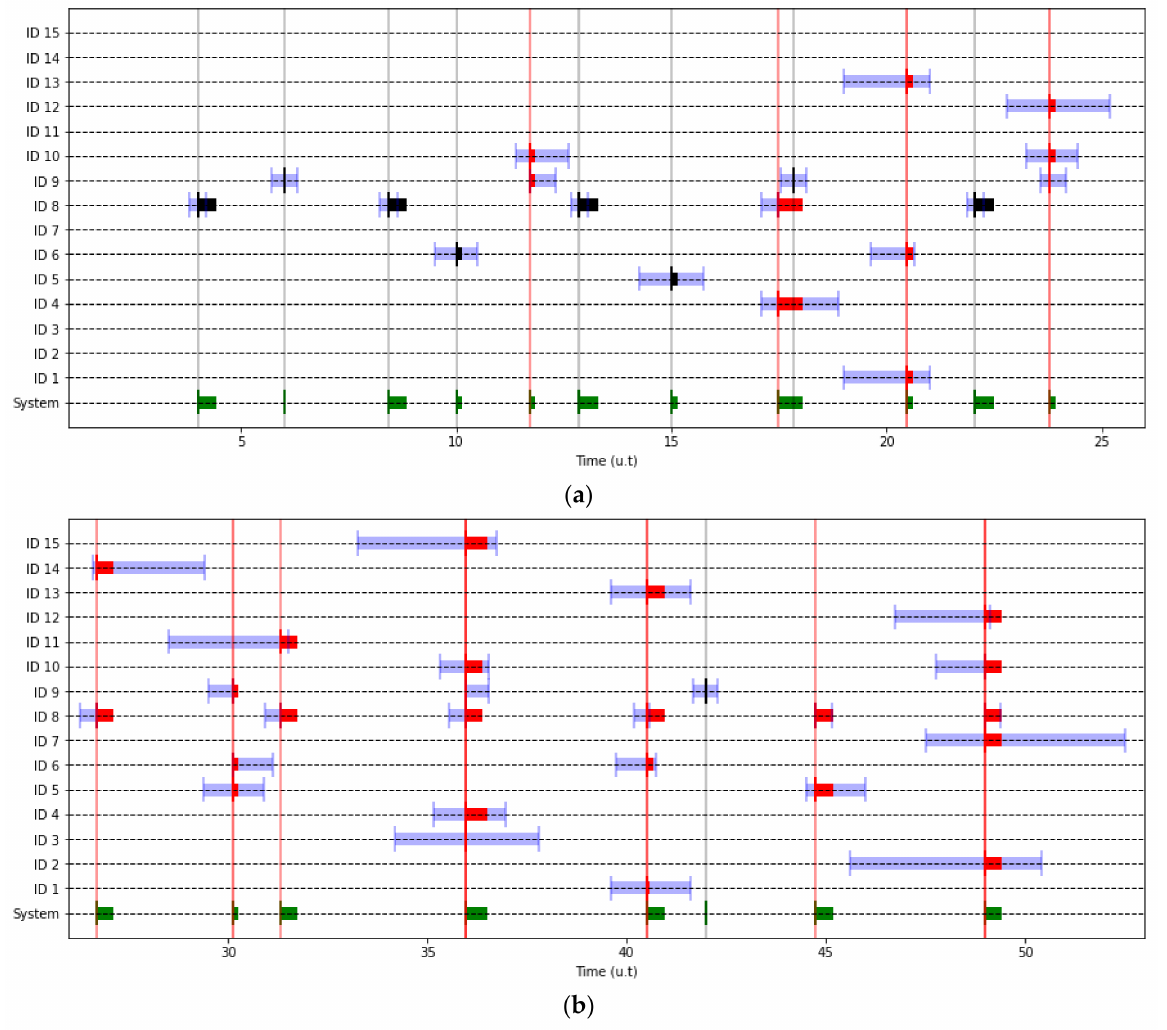
Figure 8. Optimal grouping schemes for the case study under a tolerance factor e = 5%, considering a 52-week planning horizon. ( a ) First semester (weeks 1–26); ( b ) Second semester (weeks